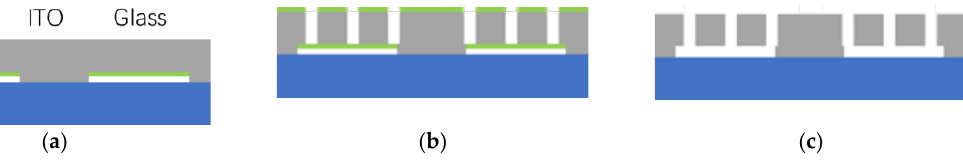
Figure 3. Preparation of the accelerometer structure: ( a ) preparation of structures; ( b ) structures etching; ( c ) structures release.